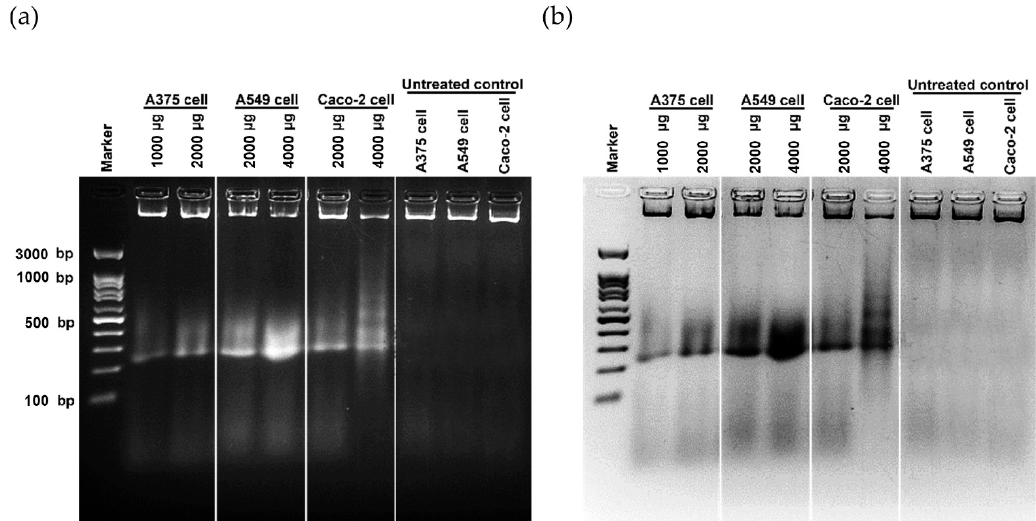
Figure 6. Deoxyribonucleic acid (DNA) fragmentation of skin cancer A375 cells, lung cancer A549 cells, and colon cancer Caco-2 cells after treatment with the ethanolic extract from cyanobacteria, Leptolyngbye sp. KC45, for 48 h when compared with control cells, i.e., normal Vero cells, by agarose gel electrophoresis ( a ) and inverting (black/white) the agarose gel ( b ). The terminal deoxynucleotidyl transferase dUTP nick end labeling (TUNEL) assay also serves as a confirmation test for the detection of apoptosis DNA fragmentation [3]. In this study, the impact of the ethanolic extract on the DNA damage of three different types of cancer cells was discovered by labeling the cancer cells with 4’,6-diamidino-2-phenyl- indole (DAPI) and TUNEL fluorescent dyes after 48 h of treatment with the extract. Stain- ing with DAPI, which emits blue fluorescence, can show whether a cell is alive or dead by revealing its nucleus. Only DNA deterioration may be detected by TUNEL labeling, which uses terminal deoxynucleotidyl transferase (TdT) to integrate labeled dUTP into free hy- droxyl termini formed after fragmentation of genomic DNA [144]. According to Figure 7, the results show that after being treated with the extract, the nuclei of all three types of cancer cells exhibited green fluorescence from TUNEL labeling; on the other hand, the nuclei of untreated cancer cells did not exhibit this fluorescence, indicating that all three types of cancer cells fragmented their DNA similarly when tested using agarose gel elec- trophoresis, confirming the effects of the ethanolic extract. According to the findings of this investigation, the ethanolic extract of Leptolyngbya sp. KC45 might potentially be used in the treatment of cancer in the future. However, further studies on the analysis of the expression of genes related to apoptosis should be investigated for a better understanding of the gene expression of molecules regulating apoptotic pathways in cancer cells treated with the extract.